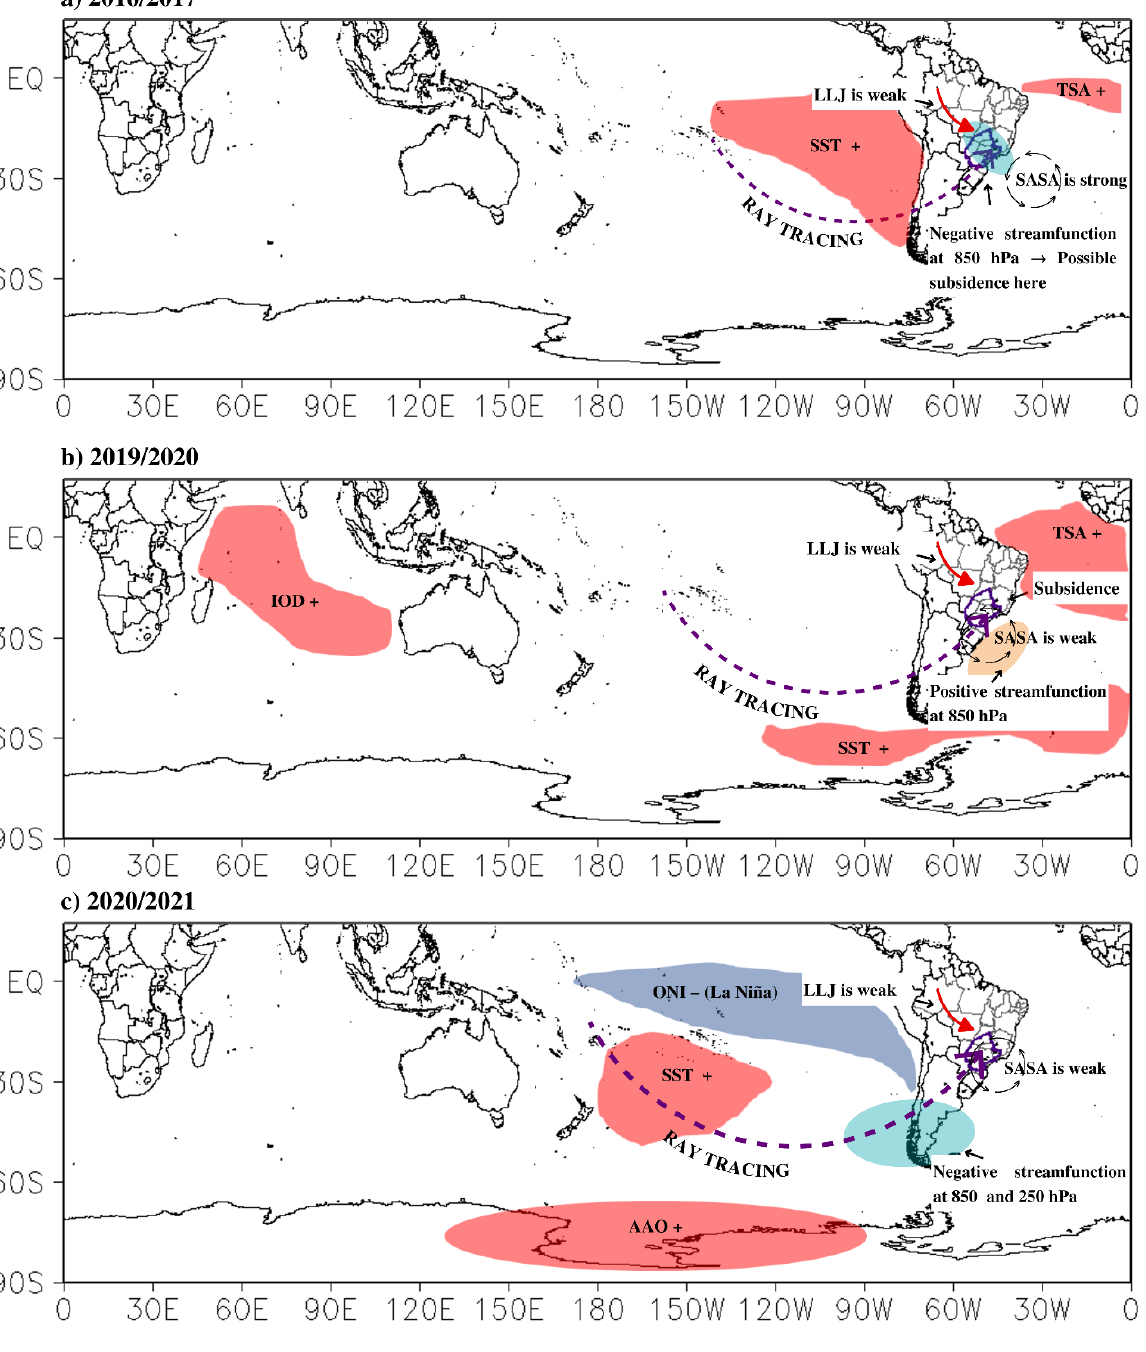
Figure 9. Scheme of atmospheric and oceanic patterns associated with droughts in the PHR for the periods: ( a ) 2016/2017; ( b ) 2019/2020; and ( c ) 2020/2021.